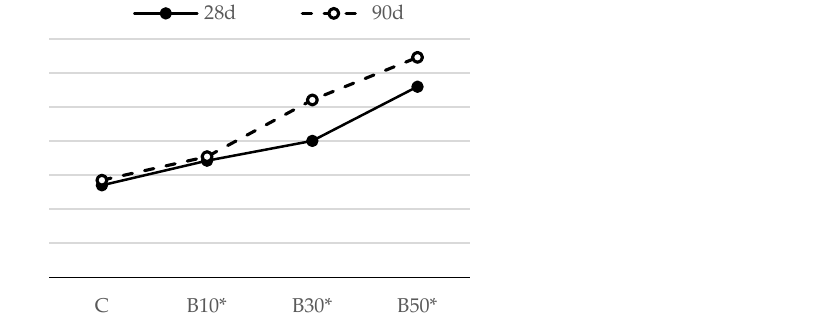
Figure 14. Flexural strength of mortars blended with biomass ash, with decreased w/b.